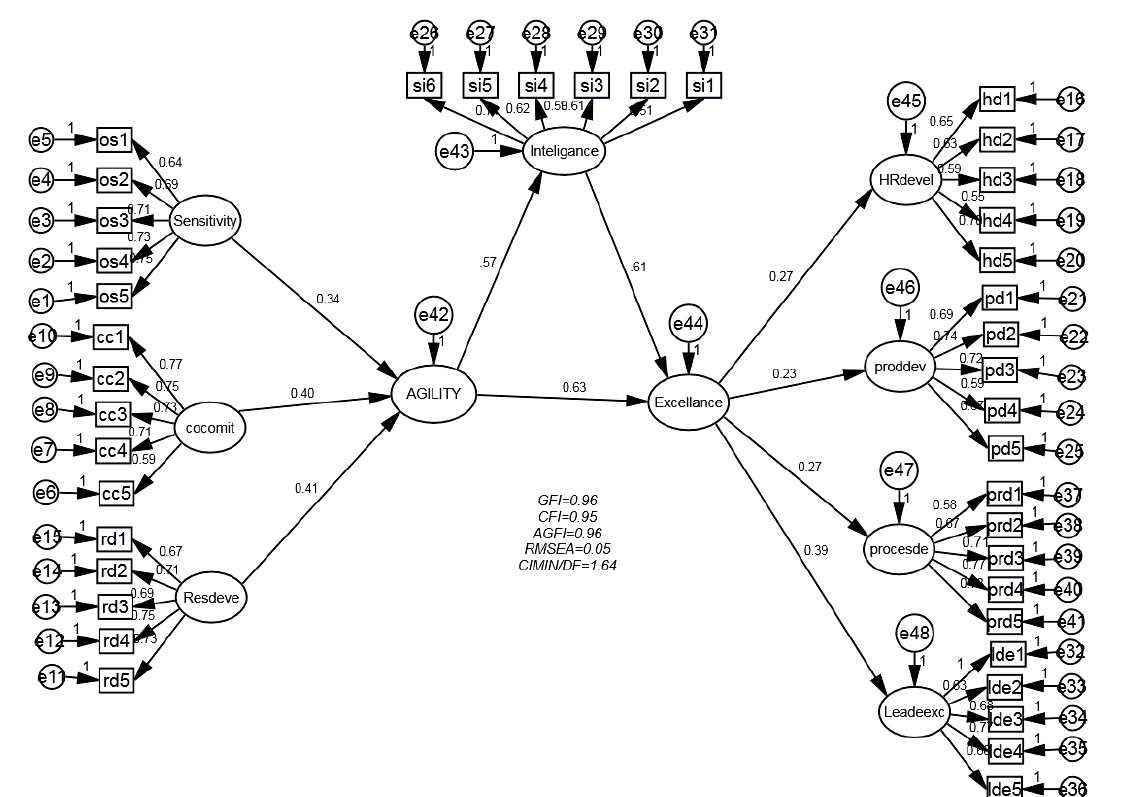
Figure 1. Structural model